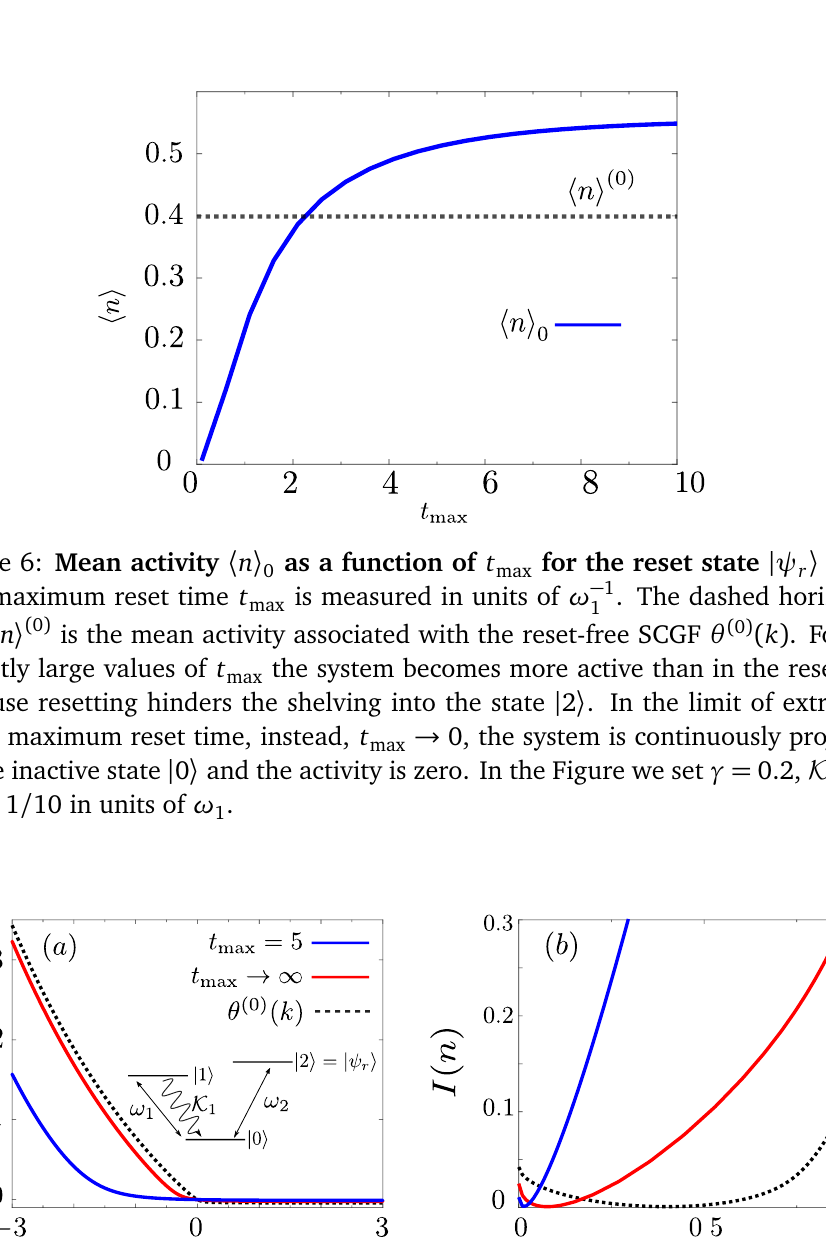
Figure 7: Three-level system reset to the shelving state | ψ cumulant generating function θ ( k ) as a function of k for t → ∞ (red solid line). The SCGF of the reset-free dissipative blue solid line) and t max process θ ( 0 ) ( k ) is shown as a black dashed curve for comparison. The three-level system is also sketched. (b) Rate function I ( n ) as a function of the activity n = N / t for the same values of t as in panel (a). Resetting favours long inactive periods and max therefore the intermittence of the quantum-jump trajectories, in contrast to the case of Fig. 5. The crossover of θ ( k ) around k = 0 gets therefore sharper and sharper as reset events become more and more frequent (low values of t deviation function I ( n ) accordingly becomes strongly asymmetric with respect to the mean value 〈 n 〉 as t is lowered. In the Figure we set γ = 0.2, K max in units of ω 1